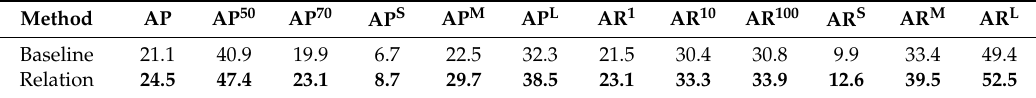
Table 8. Ablation study on MS COCO 2014 minival. All methods are trained on MS COCO train set. Baseline: Faster R-CNN our trained. Relation: only using object-object relationships. The bold characters represent the best result for each column.